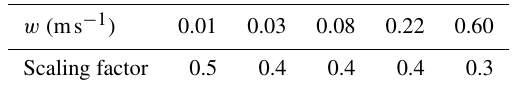
Table A1. Scaling factor that minimizes the mean squared error of the scaled default activation profile in ICON and the activation pro- file derived from CAMS for several vertical velocities in an altitude band from the surface to 700hPa.